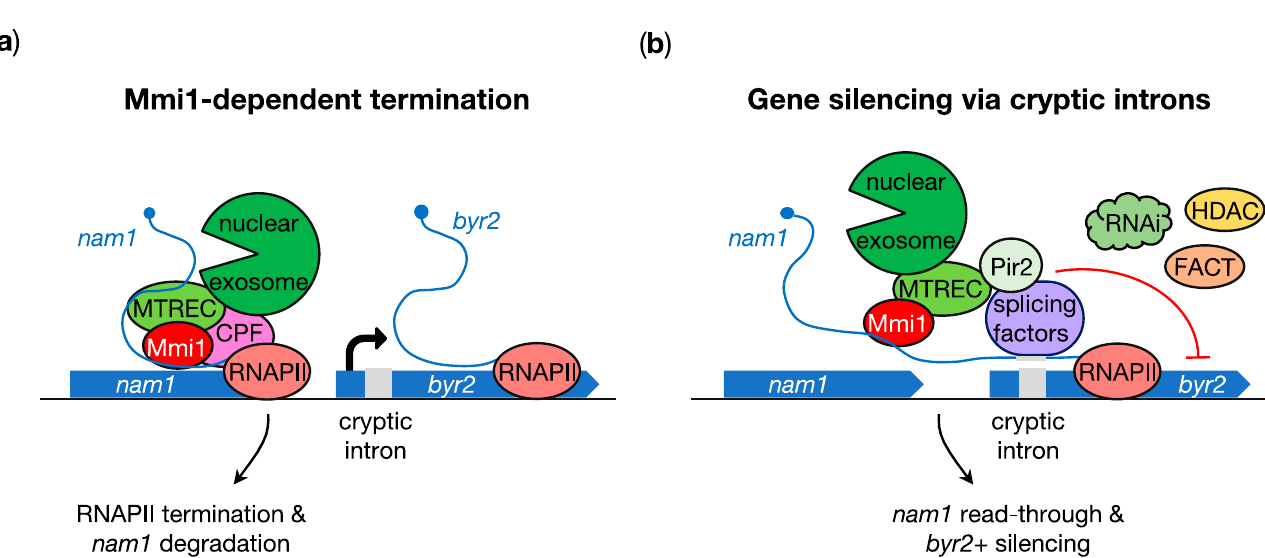
Figure 3. Control of byr2 + expression by the lncRNA nam1 . ( a ) Mmi1 associates with components of the cleavage and polyadenylation factor (CPF) to mediate RNAPII termination upstream the byr2 + gene and targets the DSR-containing lncRNA nam1 for degradation by the nuclear exosome. ( b ) Upon environmental changes, nam1 transcription extends into byr2 + and the lncRNA incorporates a cryptic intron that is recognized by splicing factors and Pir2, which in turn recruit silencing effectors (e.g., the RNAi machinery, the chromatin-remodeling FACT complex and the histone deacetylase Clr3) to repress byr2 + expression.